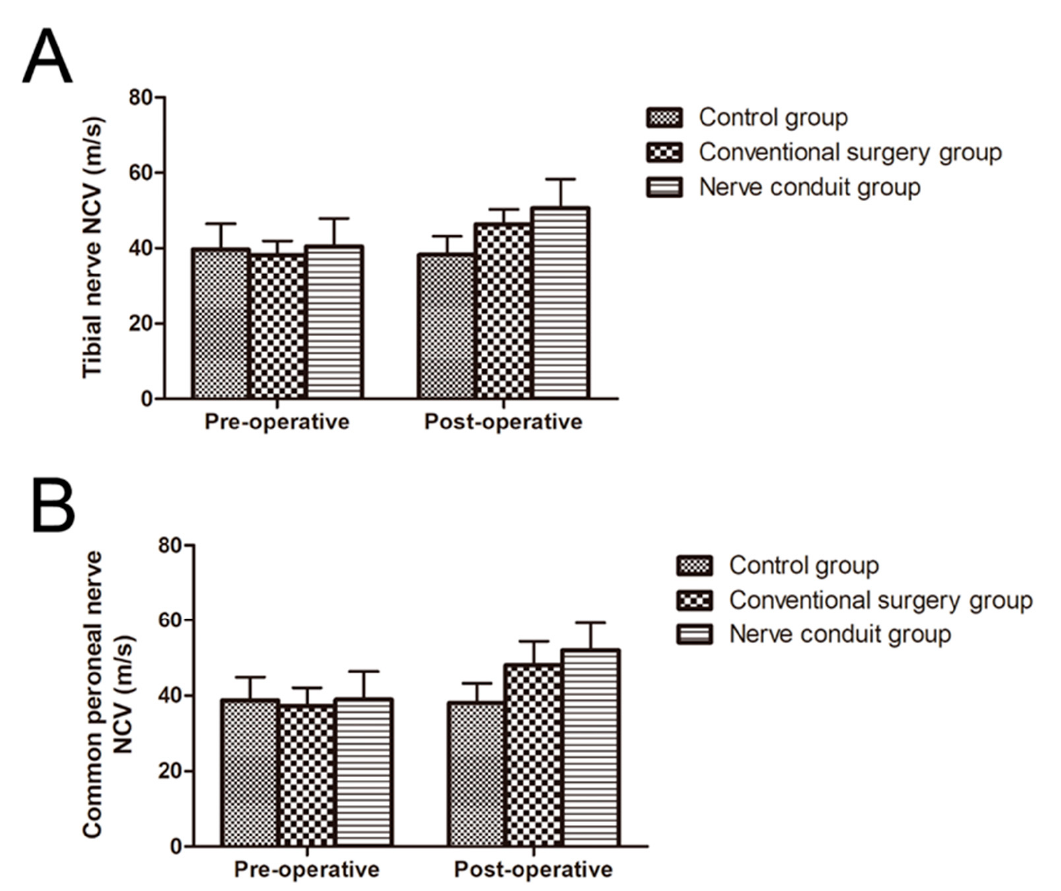
Figure 4. Pre-operative and post-operative NCVs of patients in all groups (mean ± SD). ( A ) Nerve